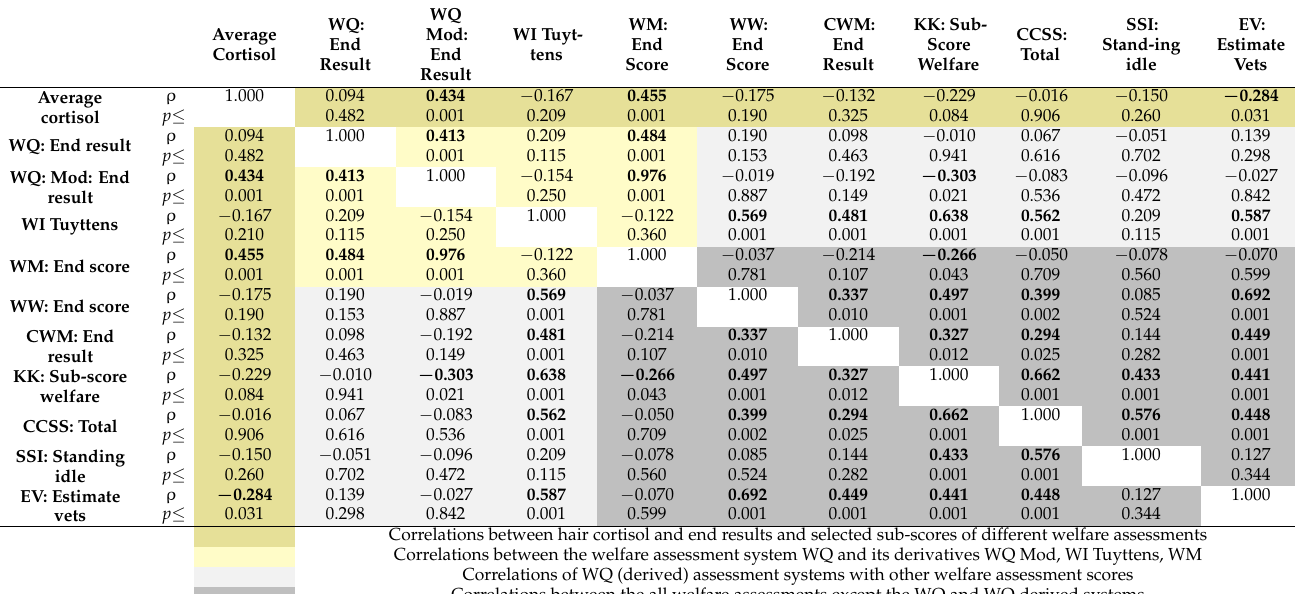
Table 2. Spearman rank correlations (Rho, ρ ) and associated probabilities between hair cortisol concentrations, relevant parameters of the various welfare assessment protocols (end results) and the estimates of the veterinarians, from 58 different farms. Correlations with associated probability ≤ 0.05 are printed bold. The only correlation supporting the hypothesized negative relationship between hair cortisol levels and a welfare score is printed bold.